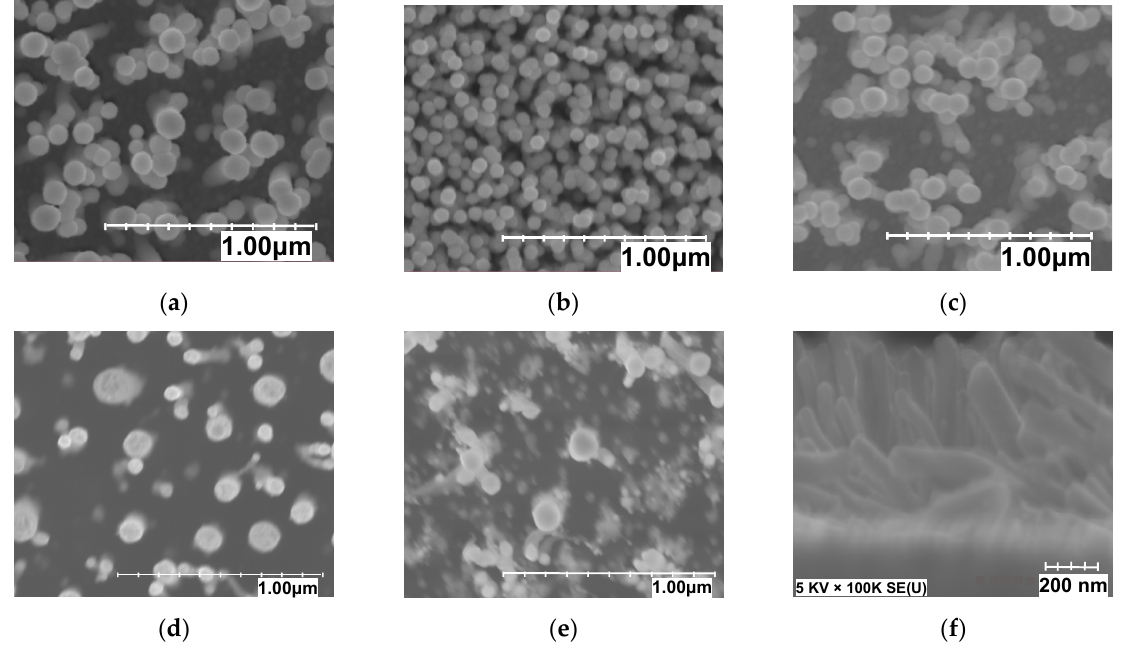
Figure 2. Fibers per area versus acetylene flow in sccm at 600 ◦ C growth temperature and 9 nm nickel catalyst. ( a ) through ( e ) are top view SEM of the three samples and other flows not further investigated in the gas testing; ( f ) is a cross section view of sample ( e ). ( a ) 25 sccm. ( b ) 20 sccm (Sample A). ( c ) 15 sccm (Sample B). ( d ) 10 sccm (Sample C). ( e ) 5 sccm. ( f ) 5